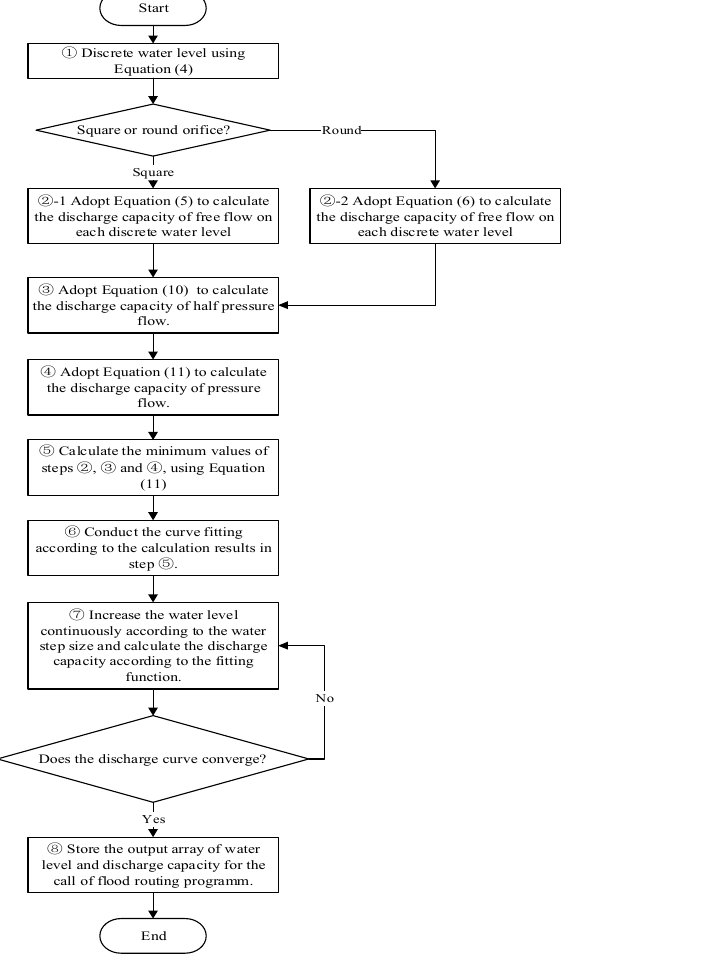
Figure 2. Flow chart of the simplified algorithm for discharge capacity of window-type draining wells.